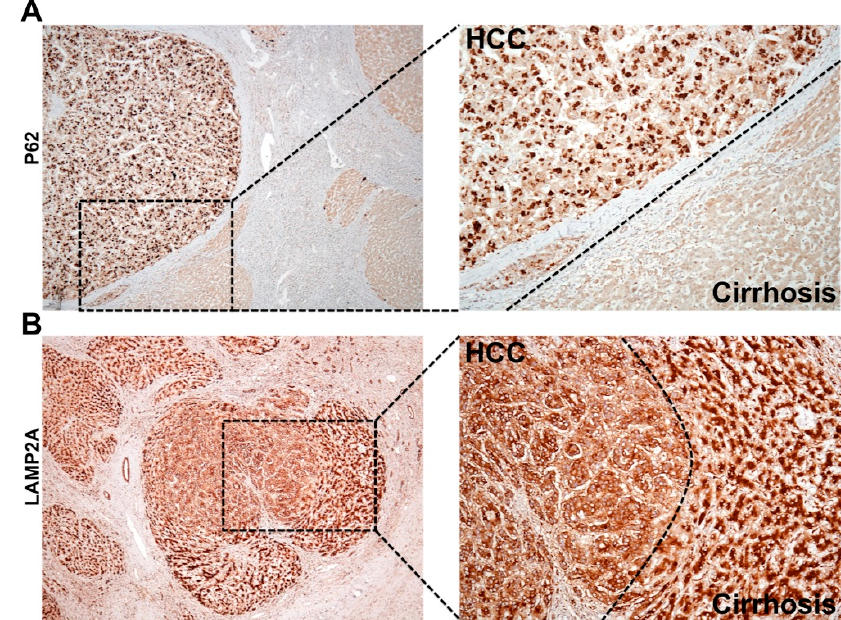
Figure 6. Shown is the immunohistochemical staining pattern of p62 and LAMP2A in HCC and surrounding non-tumor areas of the cirrhotic livers. ( A ). The appearance of p62 is significantly higher in HCC as compared to the adjacent non-tumorous cirrhotic liver, suggesting that HCC has impaired autophagy response. High-power micrograph shows cytoplasmic accumulation of p62 only in the HCC, but not the surrounding non-tumorous hepatocytes in the cirrhotic liver. ( B ). LAMP2A staining of HCC tumor nodule developed in cirrhotic areas. The LAMP2A staining is di ff erent between HCC tumors in the center and hepatocytes in surrounding non-tumorous cirrhotic areas. High-power micrograph clearly shows cytoplasmic LAMP2A staining in the tumor nodules, suggesting that CMA is activated in HCC.